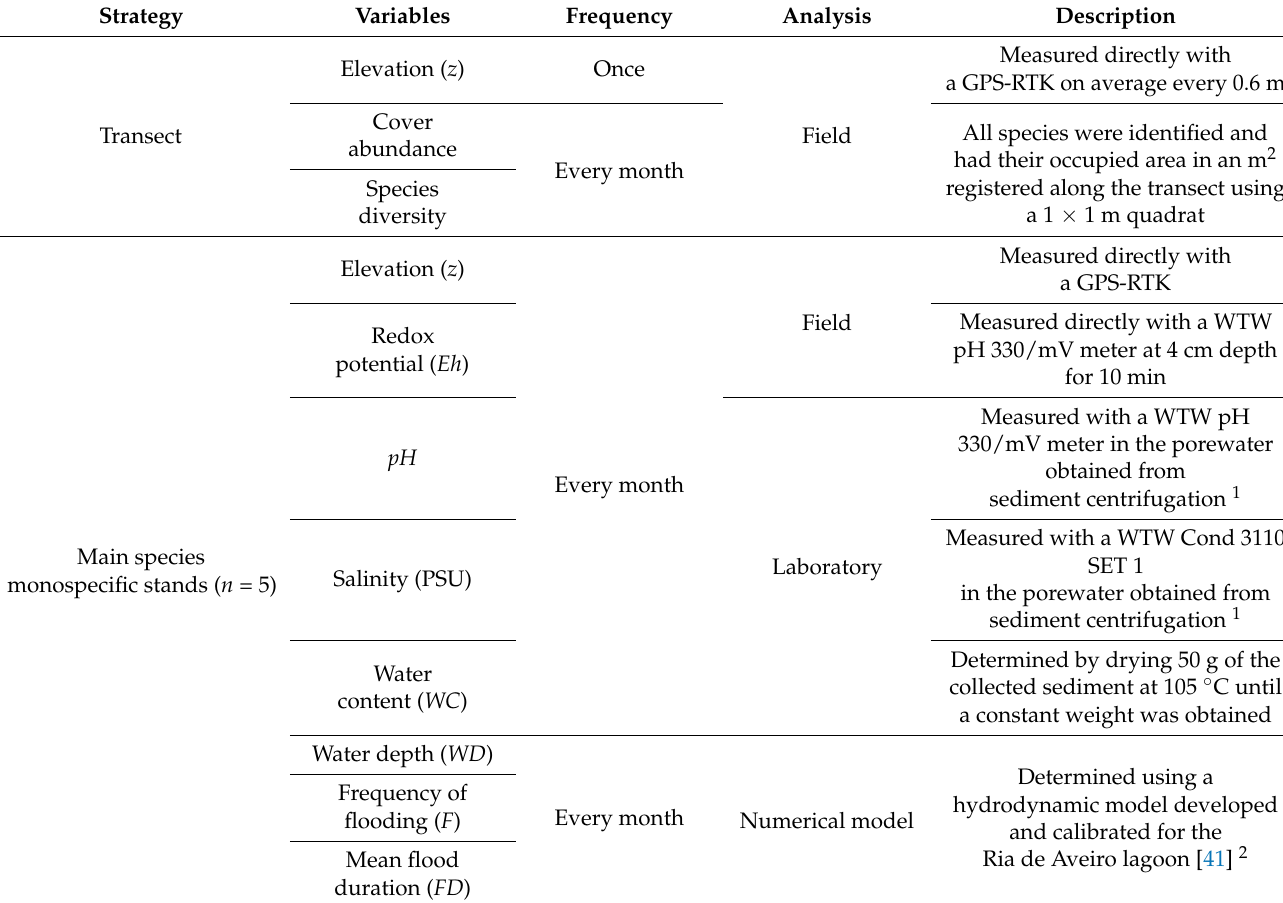
Table 1. Summary table of the different methodologies